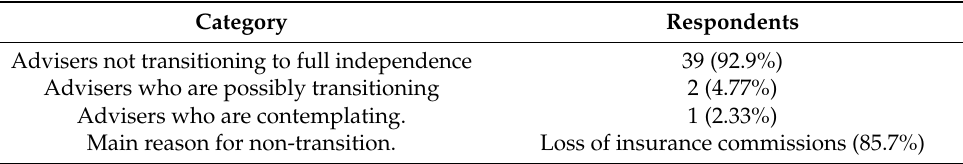
Table 2. Advisors transitioning to